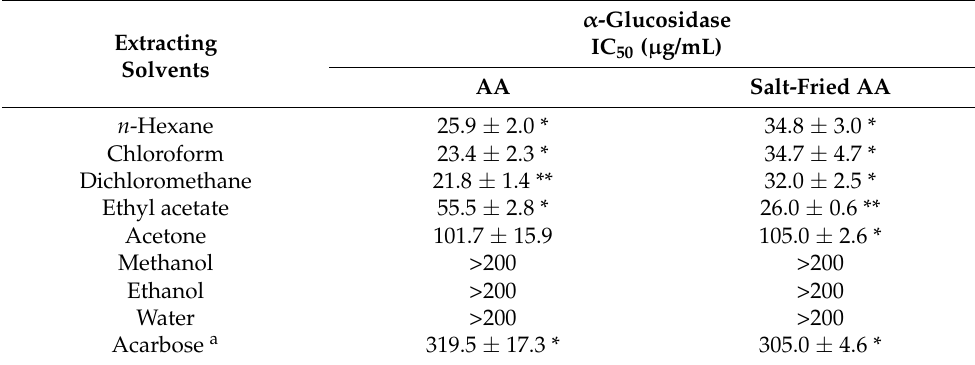
Table 3. α -Glucosidase inhibitory activities of different solvent